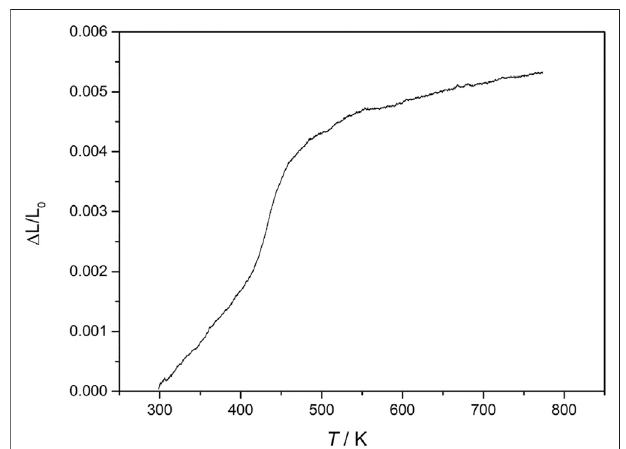
FIGURE 6 | Dilatometric heating curve of AlInW 3 O 12 phase, showing change in length ( Δ L ) relative to the original length ( L 0 ) and the monoclinic-to- orthorhombic phase transition at ca . 473 K. The low-temperature monoclinic form has higher density (lower molar volume), and therefore, there is volume expansion on transition to the lower-density (higher molar volume) orthorhombic form (Cerón Cortés et al.,